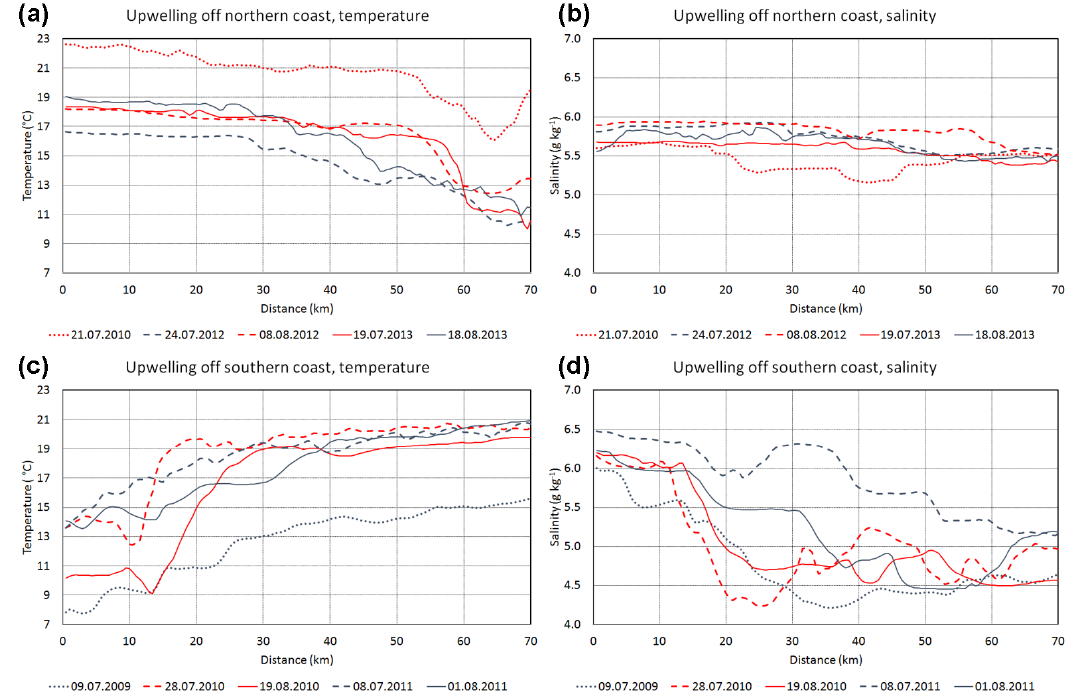
Figure 7. Characteristic distributions of temperature and salinity along the Tallinn–Helsinki ferry route with coastal upwelling events off the northern coast (a, b) and off the southern coast (c, d) ; x axis shows the distance from Tallinn Bay (latitude 59.48N) in km along the meridional